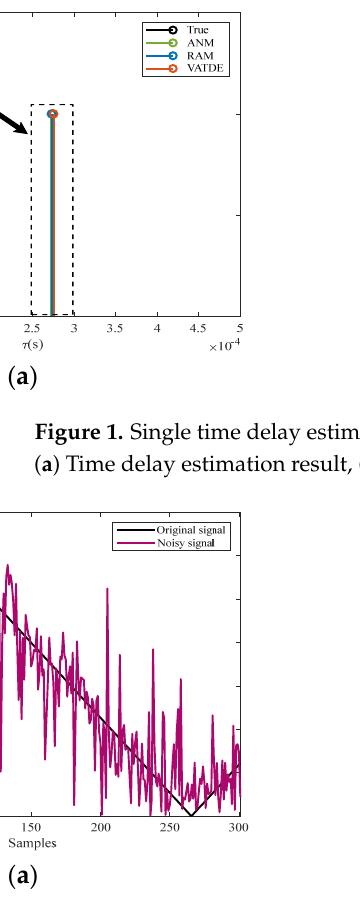
Figure 2. Phase reconstruction performance of different algorithms in the case of SNR 10 dB. ( a ) Original signal phase and noisy, ( b ) reconstruction results of signal phase by different algorithms.